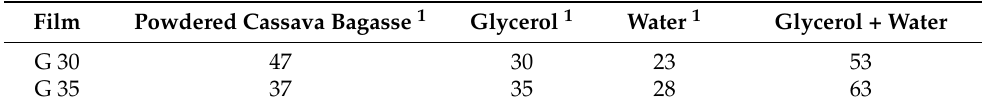
Table 1. Formulations for film-forming mixtures for the hot-press